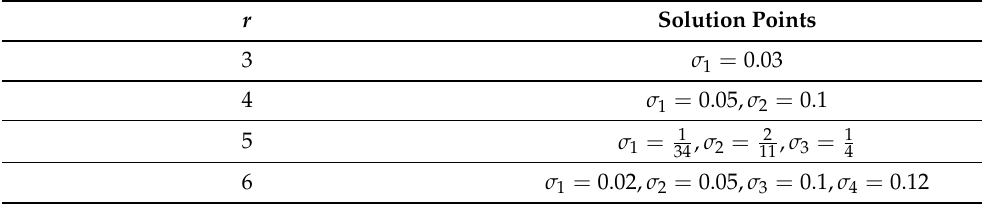
Table A1. Choice of { σ i } for solution points. r Solution